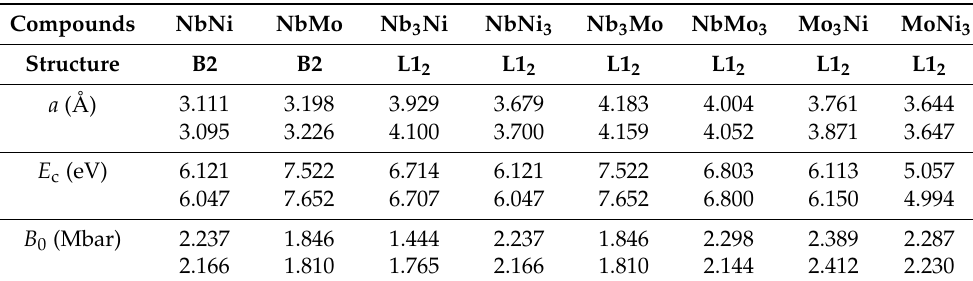
Table 3. Lattice constants ( a , Å), cohesive energies ( E c , eV), and bulk moduli ( B 0 , Mbar) of B2 and L1 2 compounds in the Ni-Nb-Mo system derived from the potential (first line) and first-principle calculation (second line) [55].